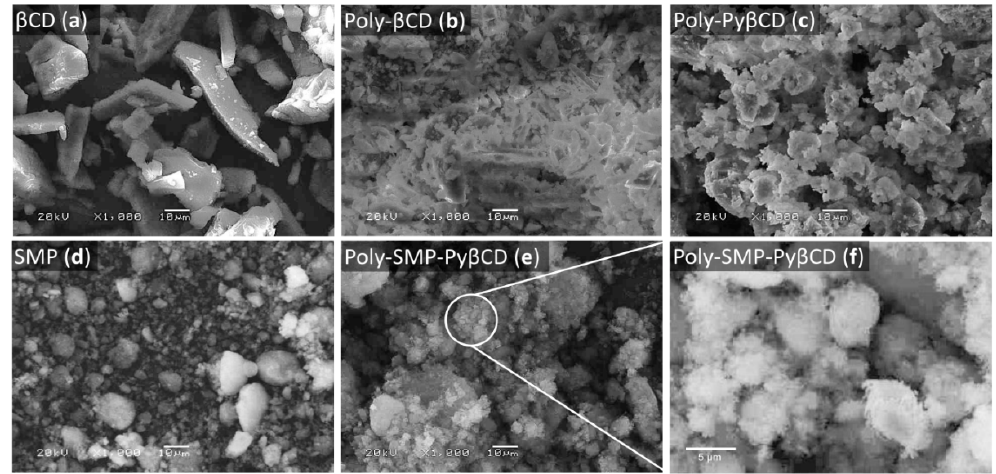
Figure 1. SEM images of the β CD ( a ); Poly- β CD ( b ); Poly-Py β CD ( 3 , c ); silica micro-particles (SMP, d ), and Poly-SMP-Py β CD ( 4 , e , f ).